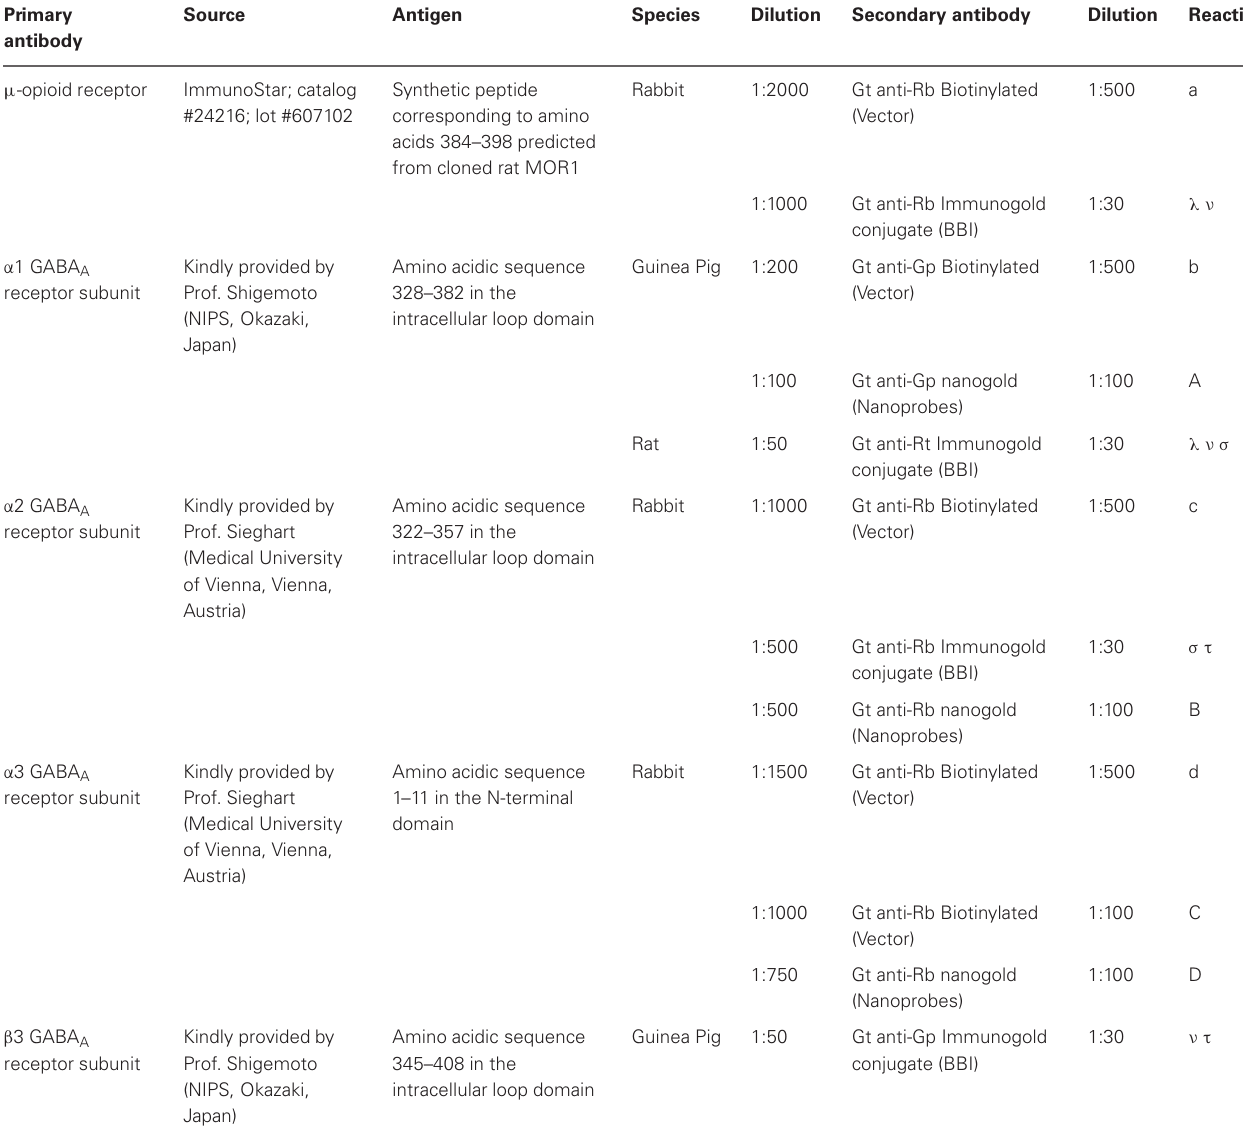
Reactions performed for light microscopy are indicated by small letters, those for pre-embedding electron microscopy by capital letters, whereas symbols identify reactions for SDS-FRL.